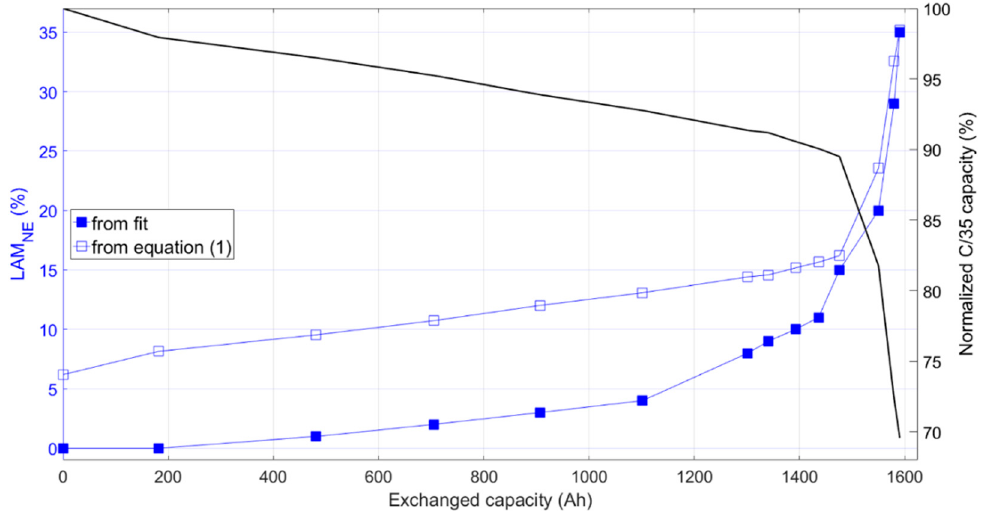
Figure 11. The percent LAM NE , plating threshold, and normalized capacity of the corresponding cell as it aged.